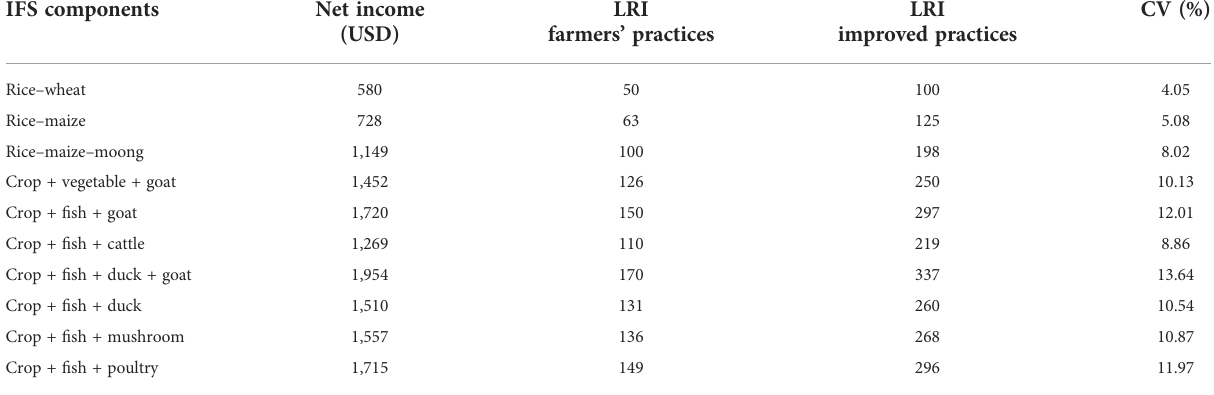
TABLE 8 Net income and link relative index (LRI) of different integrations (mean value of 6 years, 2016 – 2021). IFS